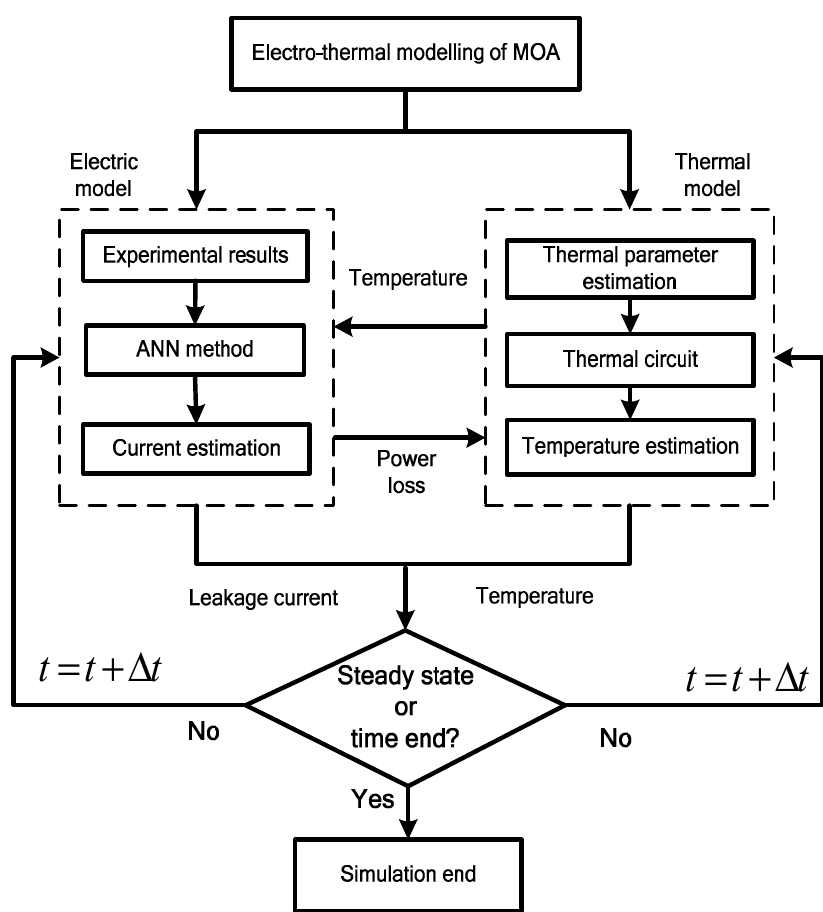
Figure 3. Calculation diagram for electrothermal characteristics’ estimation.